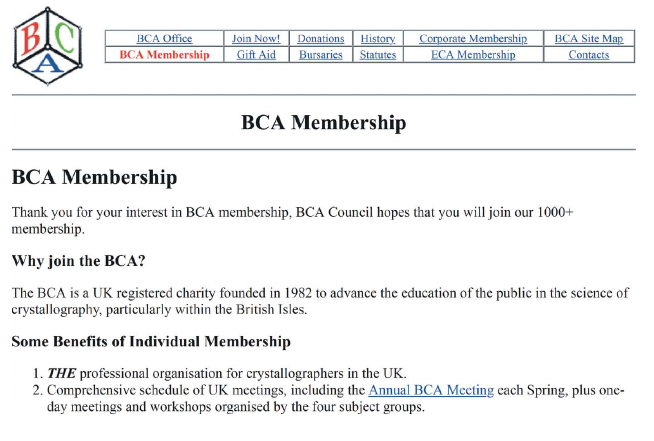
Figure 9 Second of two slides illustrating placement of the 2 axis in the monoclinic system (slide 4, Chapter 2).